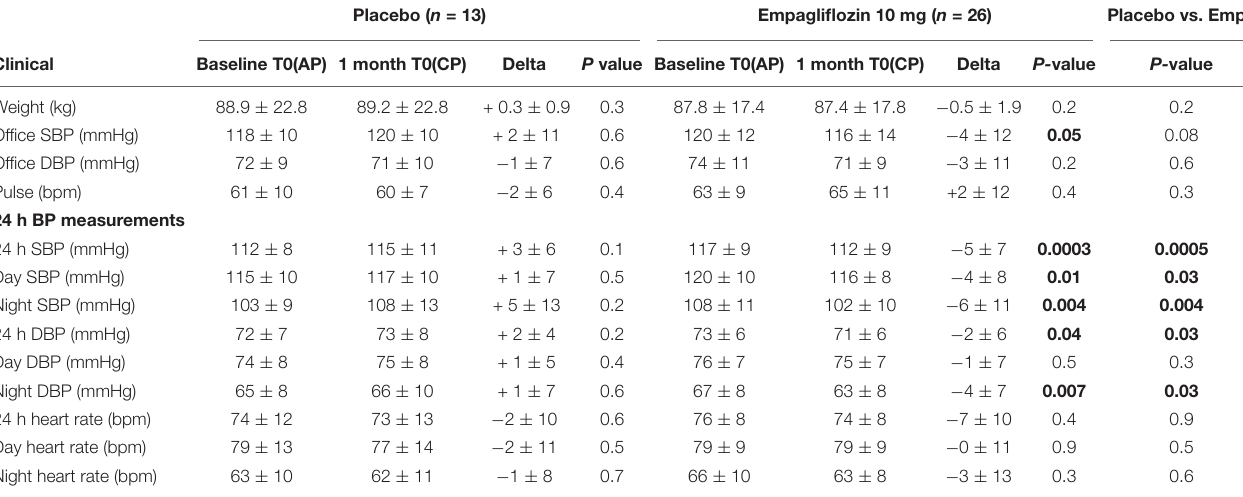
TABLE 4 | Office and ambulatory blood pressures measured after 1 month of placebo or empagliflozin 10 mg in normotensive subjects. Placebo ( n = 13) Empagliflozin 10 mg ( n = 26) Placebo vs.